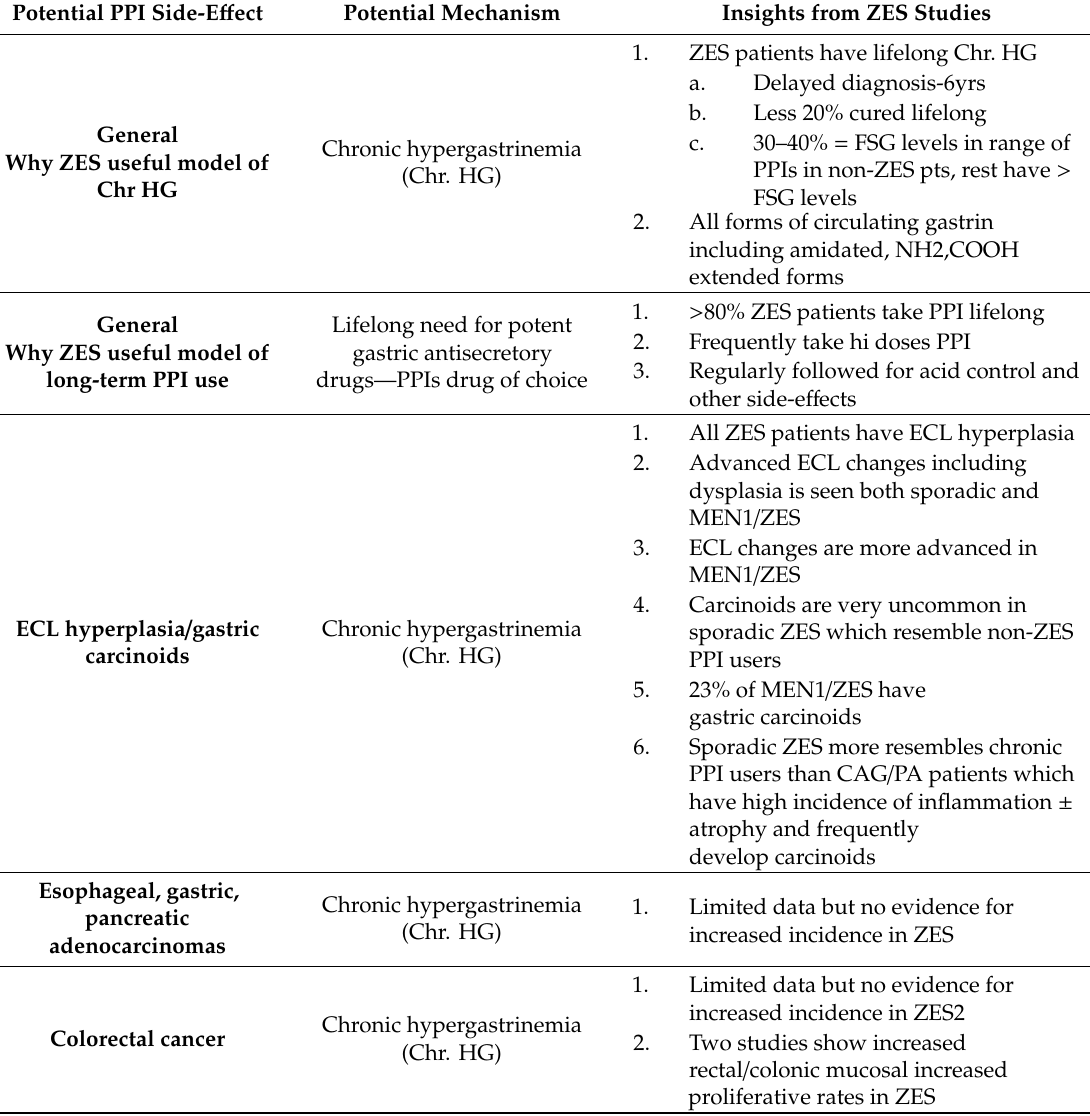
Table 1. Summary of potential side-e ff ects of PPIs and insights from studies of patients with gastrinomas causing ZES with chronic hypergastrinemia (Chr. HG) and with acid hypersecretion controlled by very long-term treatment with